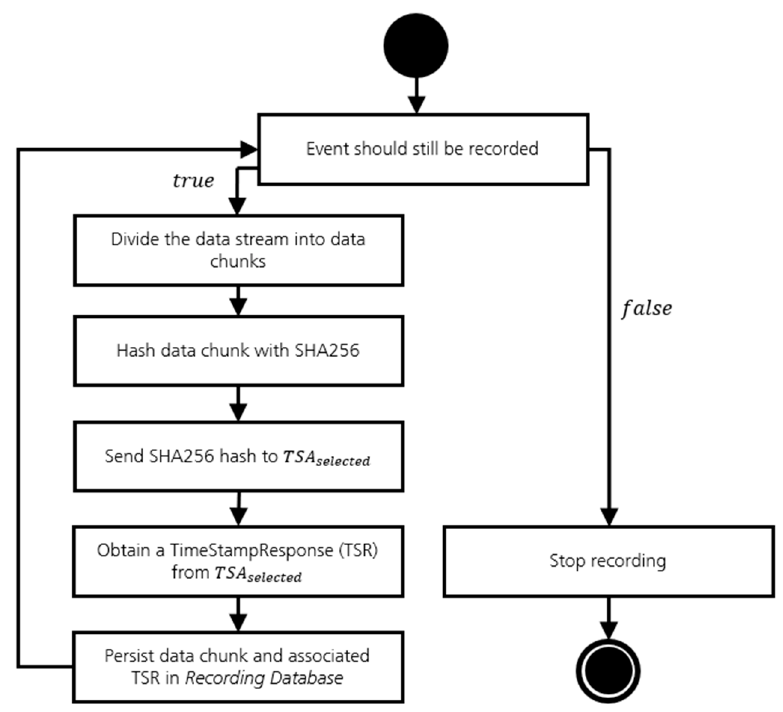
Figure 5. Procedure for local data recording and signing.